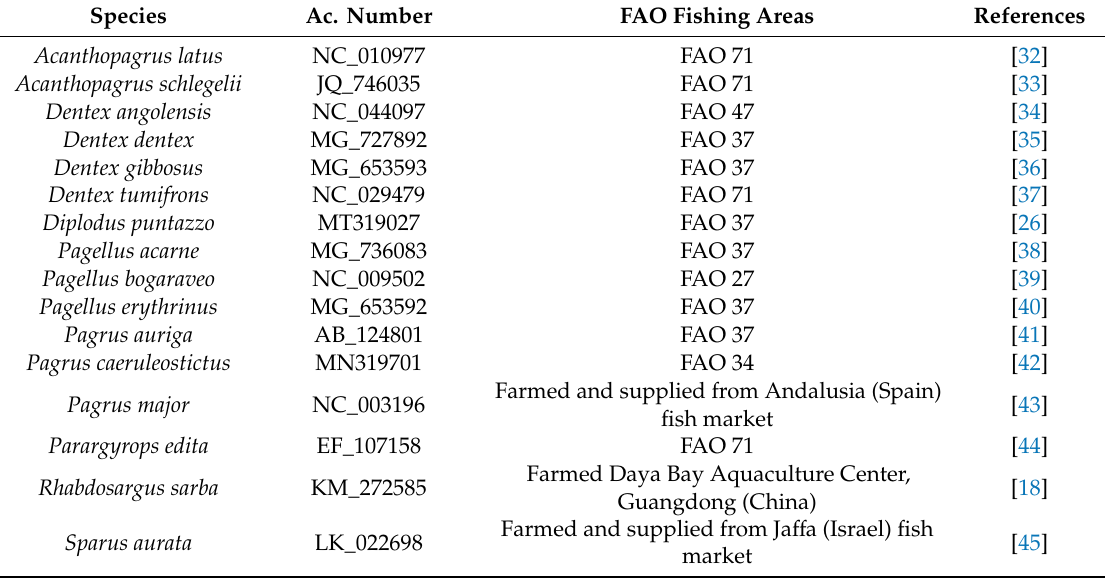
Table 4. Sparids species with whole mtDNA sequences available in GenBank evaluated in this research. Species Ac. Number FAO Fishing